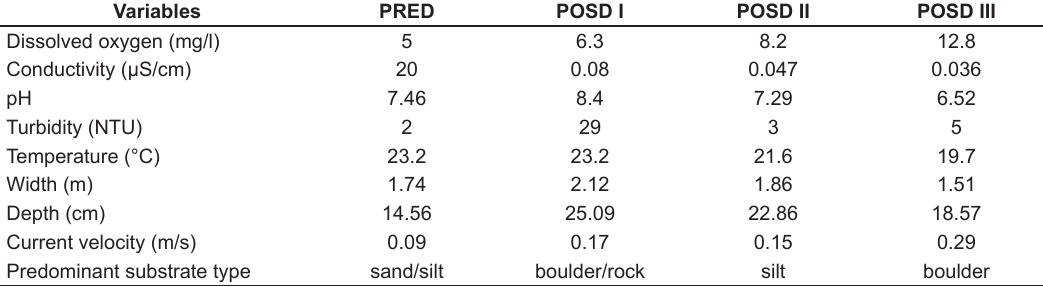
Table 1. Mean values of environmental variables sampled in the sampling periods (pre-disturbance - PRED; post- disturbance I - POSD I; post-disturbance II - POSD II; and post-disturbance III - POSD III).